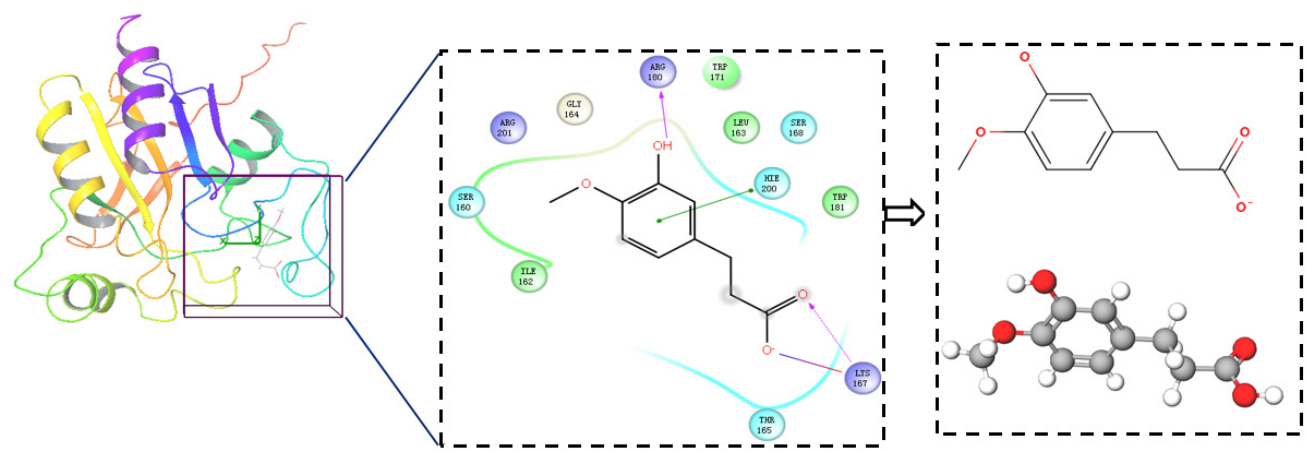
Figure 2. The docking results of FA with the active site of 2I3Y and the determined skeleton structure (green means Pi–Pi stacking, pink means H-bond, and the transition color means salt bridge).